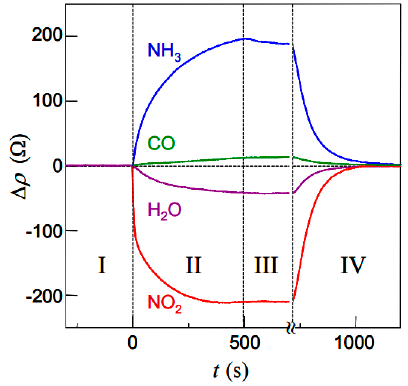
Figure 4. Chemical sensitivity of grapheme